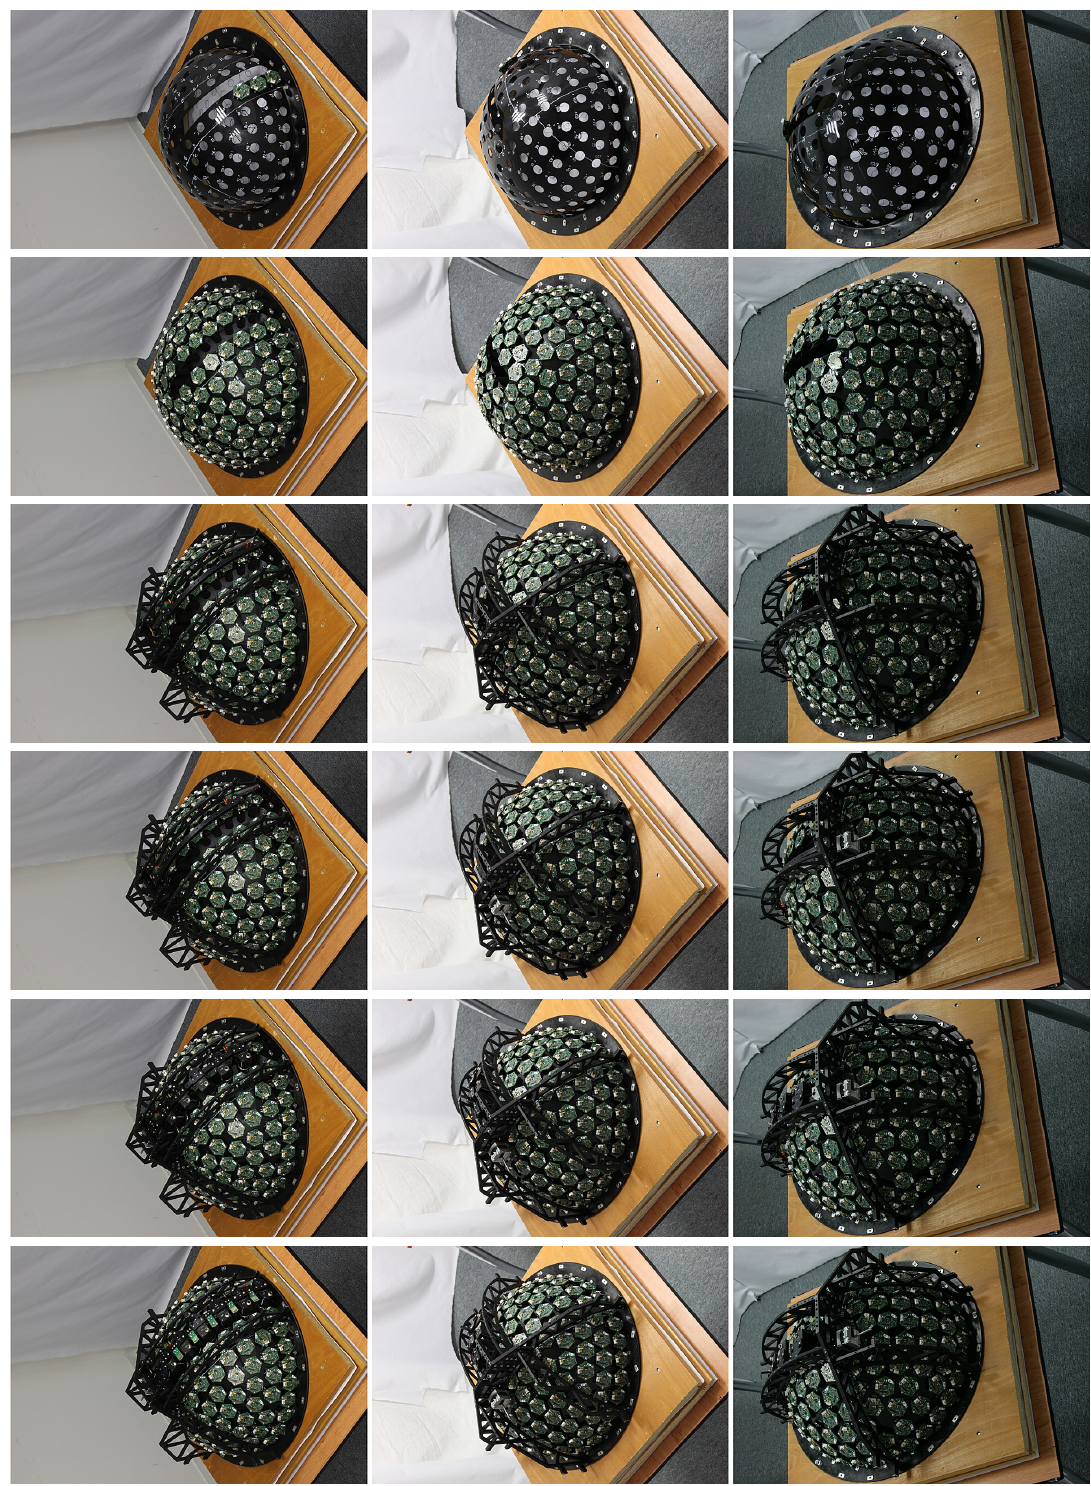
Figure A1. Assembly of lightdrum, step 1 to 6 from three different views. Row 1: populating first three LED modules; Row 2: populating all 134 LED modules; Row 3: mounting inner aluminium frame; Row 4: mounting stepper motor with trapezoidal screw; Row 5: mounting six cameras; Row 6: mounting five simplified LED modules inbetween